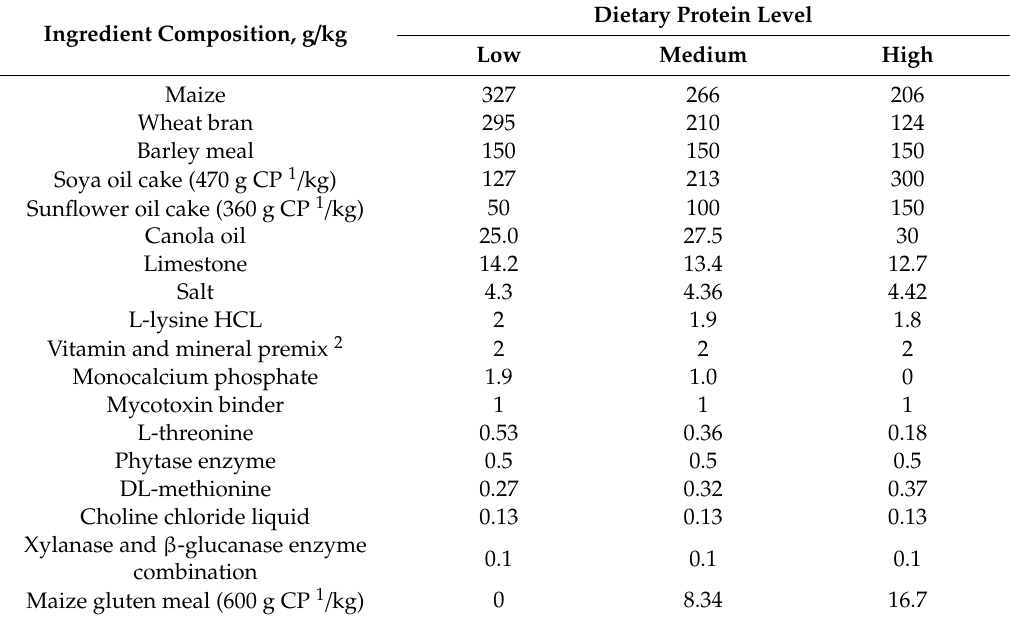
Table 1. The ingredient and nutrient composition (as-is basis) of the various dietary protein finisher diets fed to immunocastrated and entire male pigs from 20 to 24 weeks of age, with or without ractopamine hydrochloride supplementation ( n =